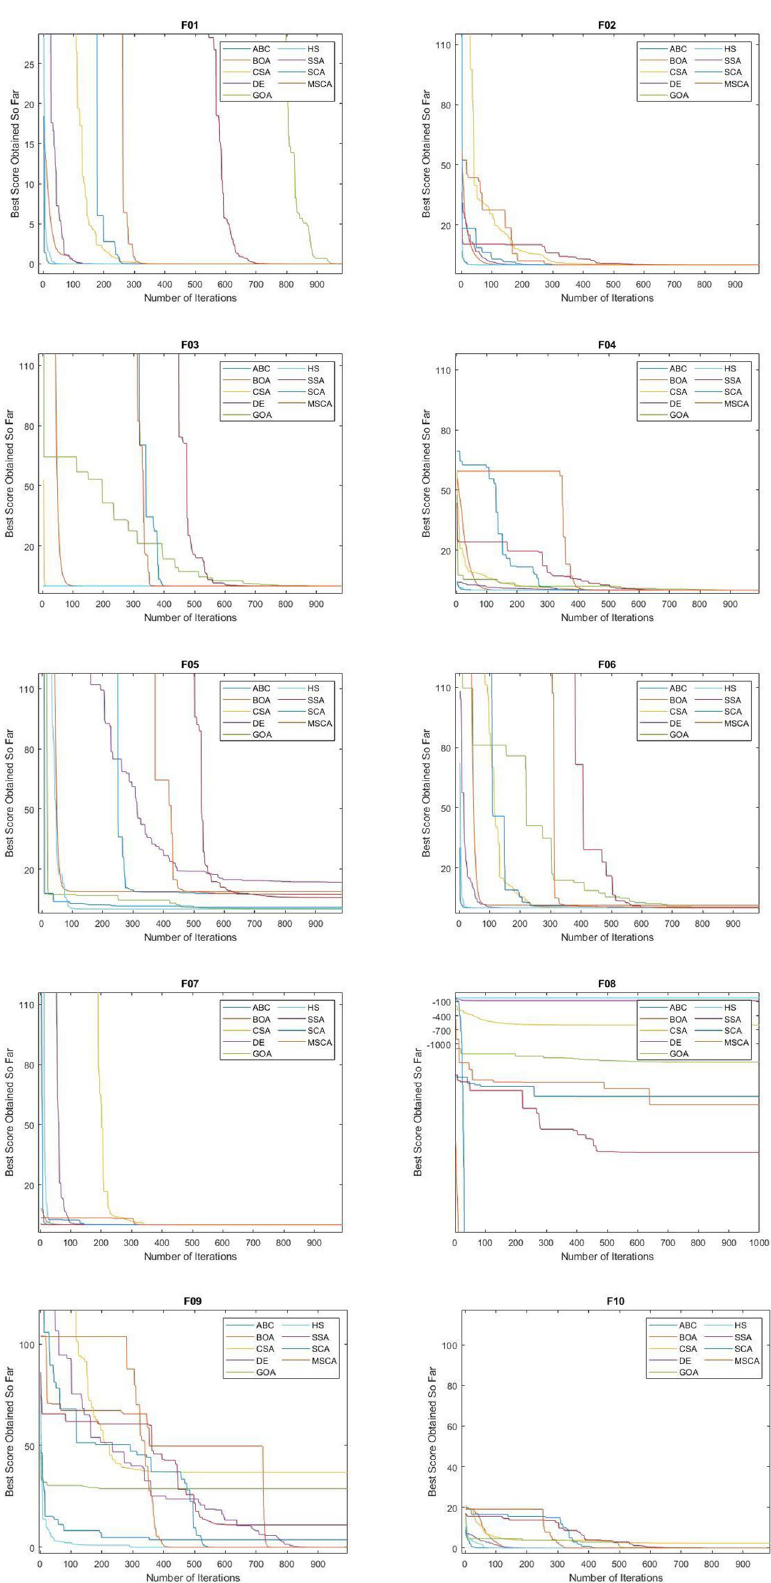
Fig 6. Convergence performance of MSCA algorithm on unimodal and multimodal functions. https://doi.org/10.1371/journal.pone.0255269.g006 PLOS ONE | https://doi.org/10.1371/journal.pone.0255269 August 6,